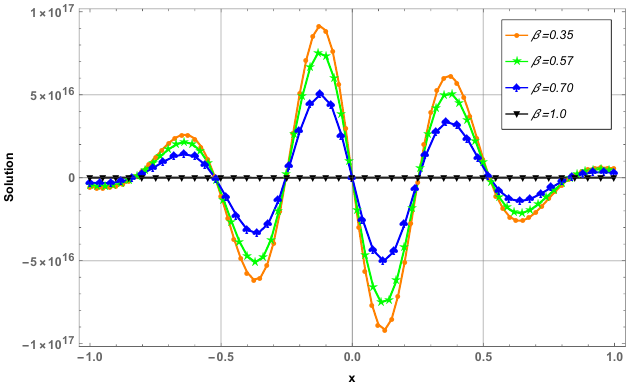
Figure 9. 2D surface formation at different values of β in Example 2 when k = 1, t =